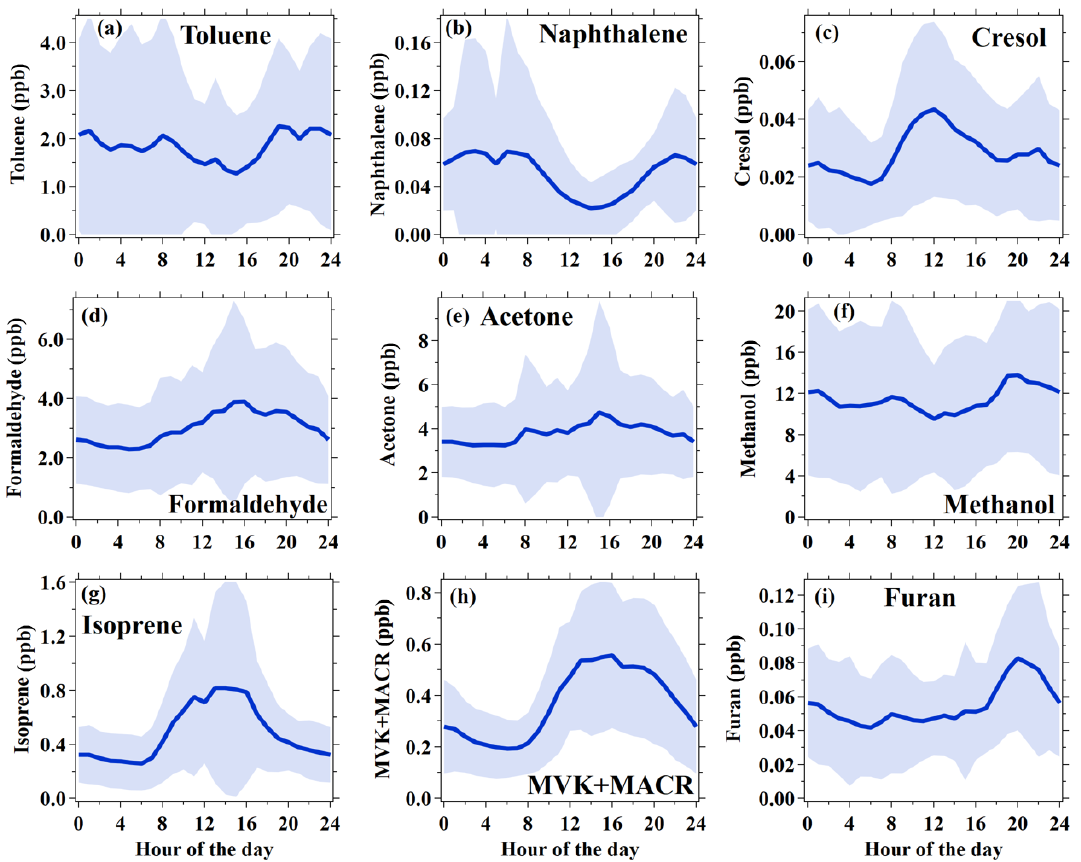
Figure 1. Diurnal variations in selected VOCs measured by PTR-ToF-MS during the campaign. Blue lines and shading represent averages and standard deviations,